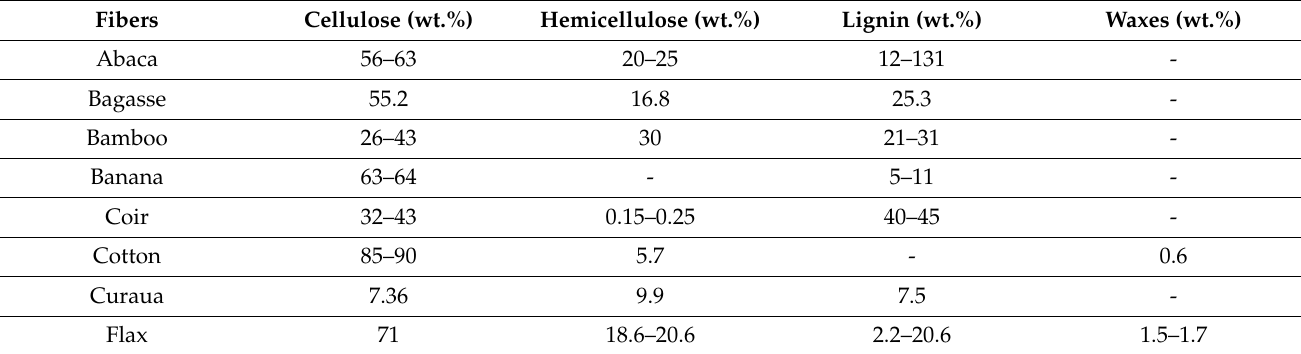
Table 3. Chemical composition of natural fibers